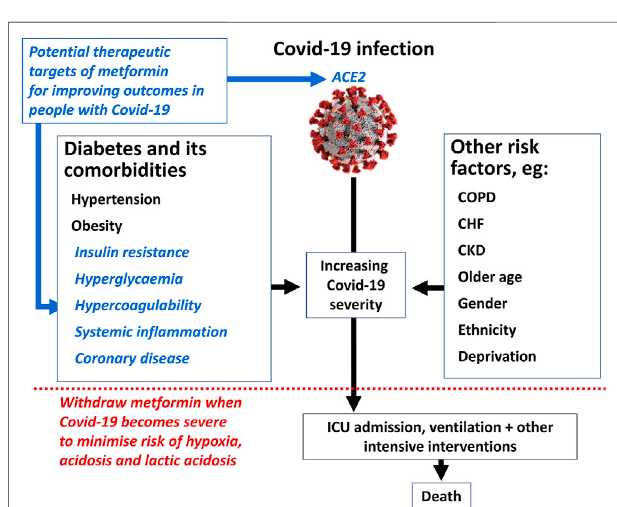
FIGURE 4 | Summary of the potential mechanisms by which metformin might in fl uence the course of severe Covid-19 infection. ICU, intensive care unit; CHF, congestive heart failure; CKD, chronic kidney disease; COPD, chronicobstructivepulmonarydisease.Seetextforreferences.Imageof coronavirus by permission of US Centers for Disease Control (https://www. cdc.gov/media/subtopic/images.htm).